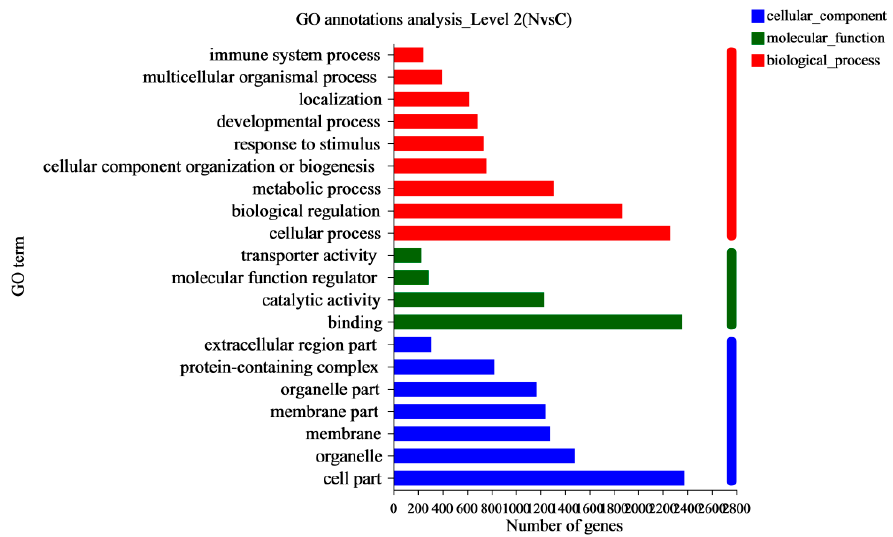
Figure 4. Genetic ontology analysis and classification statistics. The ordinate represents the second- level classification, and the abscissa represents the number of genes. The different colors represent molecular function, cellular components, and biological processes.